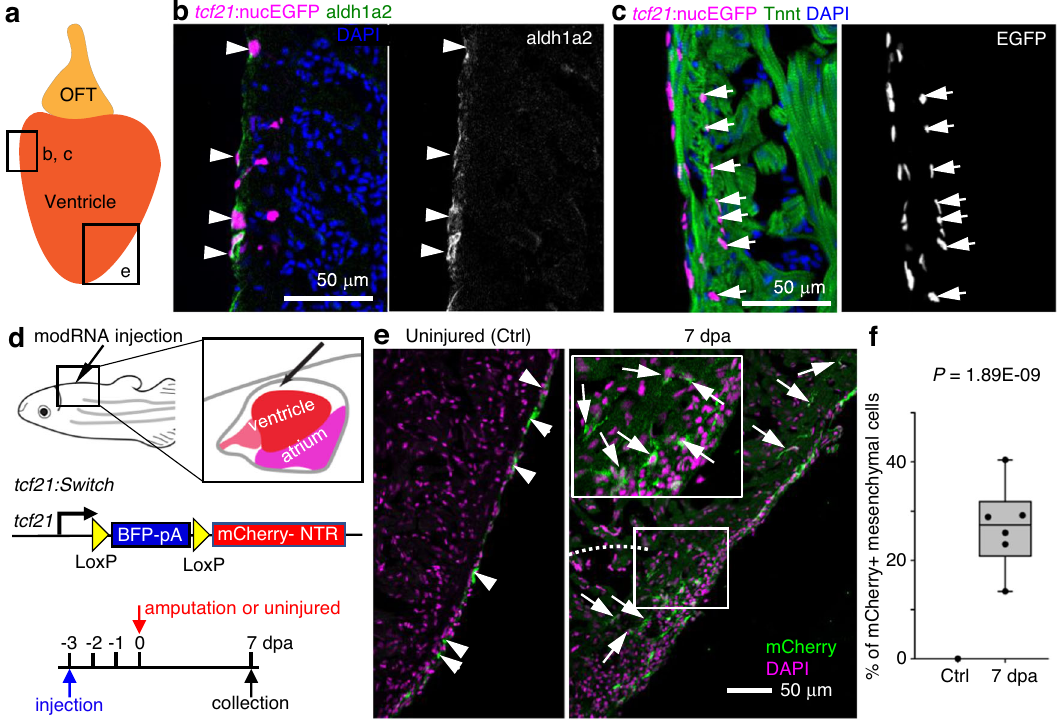
Fig. 1 | Cellular heterogeneity and EMT of tcf21 + cells in the zebra fi sh heart. a Cartoonofanadultzebra fi shheartshowingtheventricleandout fl owtract(OFT). The frames indicate representative regions for cryosection-section images in b , c and e . b A cryosection image of an uninjured heart showing tcf21: nucEGFP in magenta,antibodystainingagainstaldh1a2ingreen.NucleiwerestainedwithDAPI (blue).Asingle-channel image of aldh1a2signals is shown in grayscale onthe right. ArrowheadsindicateEGFP + adh1a2 + cells.Scalebar,50 μ m. c Acryosectionimageof an uninjured heart showing tcf21: nucEGFP in magenta, antibody staining against Tnntingreen.NucleiwerestainedwithDAPI(blue).Asingle-channelimageofEGFP is shown in grayscale on the right. Arrows indicate EGFP + mesenchymal epicardial